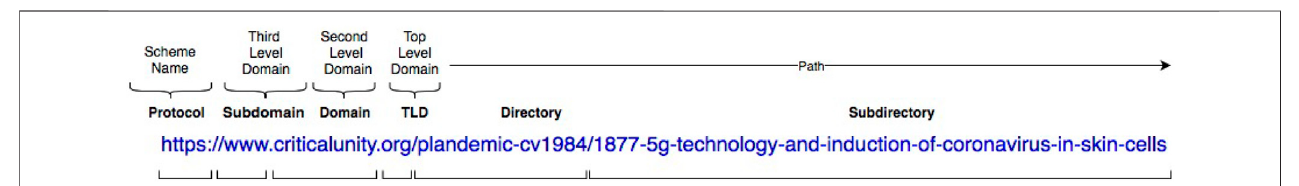
FIGURE 5 | URL ’ s structure. A URL may contain mandatory (scheme and third-level, second-level, and top-level domains) and optional (path) parts.